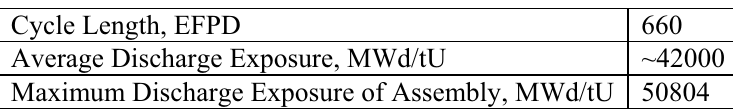
Table VII. : Main Results of Boron-Free